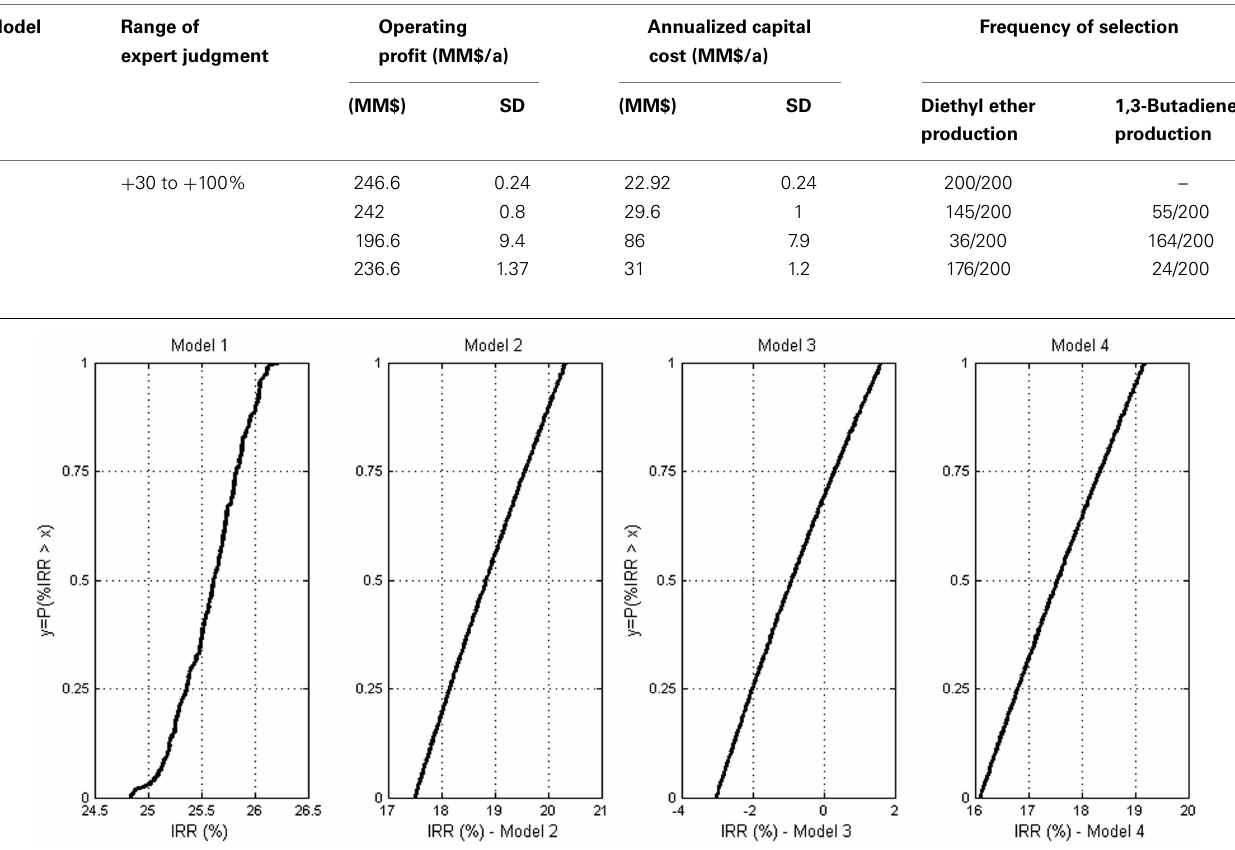
Table 12 | Uncertainty mapping and analysis: frequency of selection with respect to 200 input uncertainty scenarios .